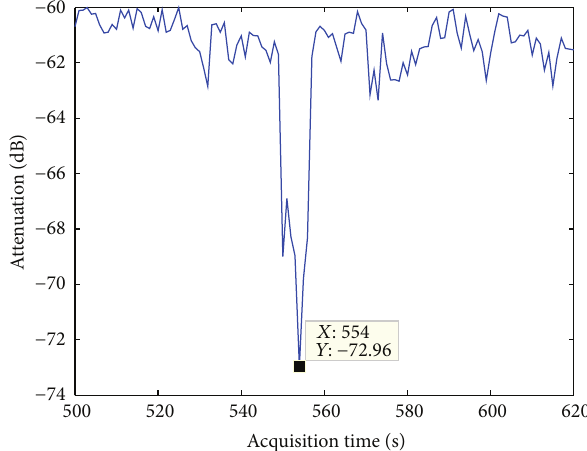
Figure 12: Measured attenuation of power arch supply.